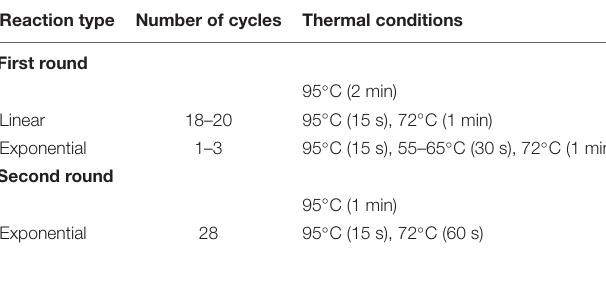
TABLE 1 | Cycling conditions for PST-PCR